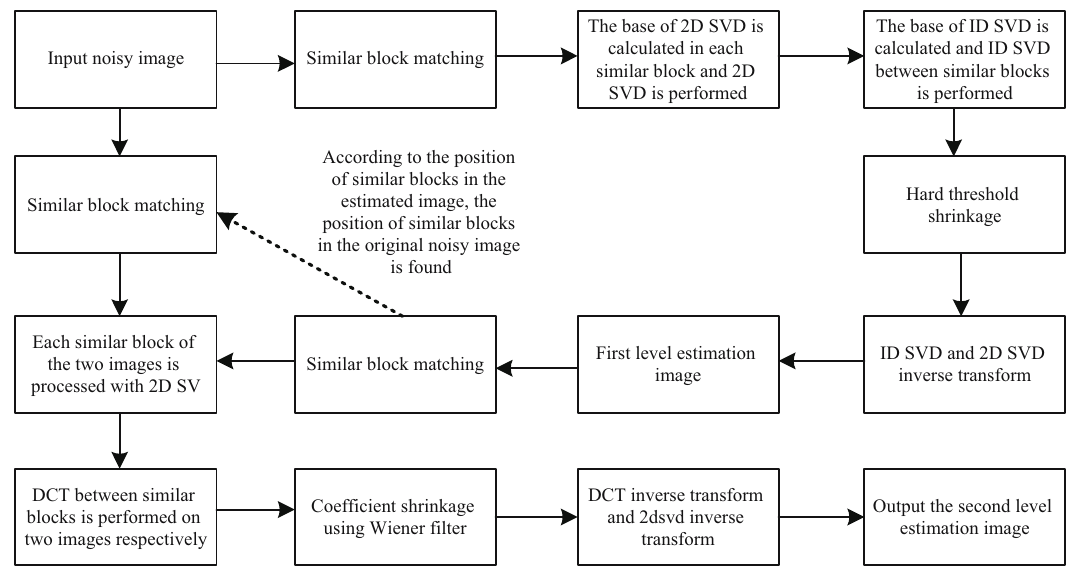
Figure 1: Image feature acquisition process of block singular value